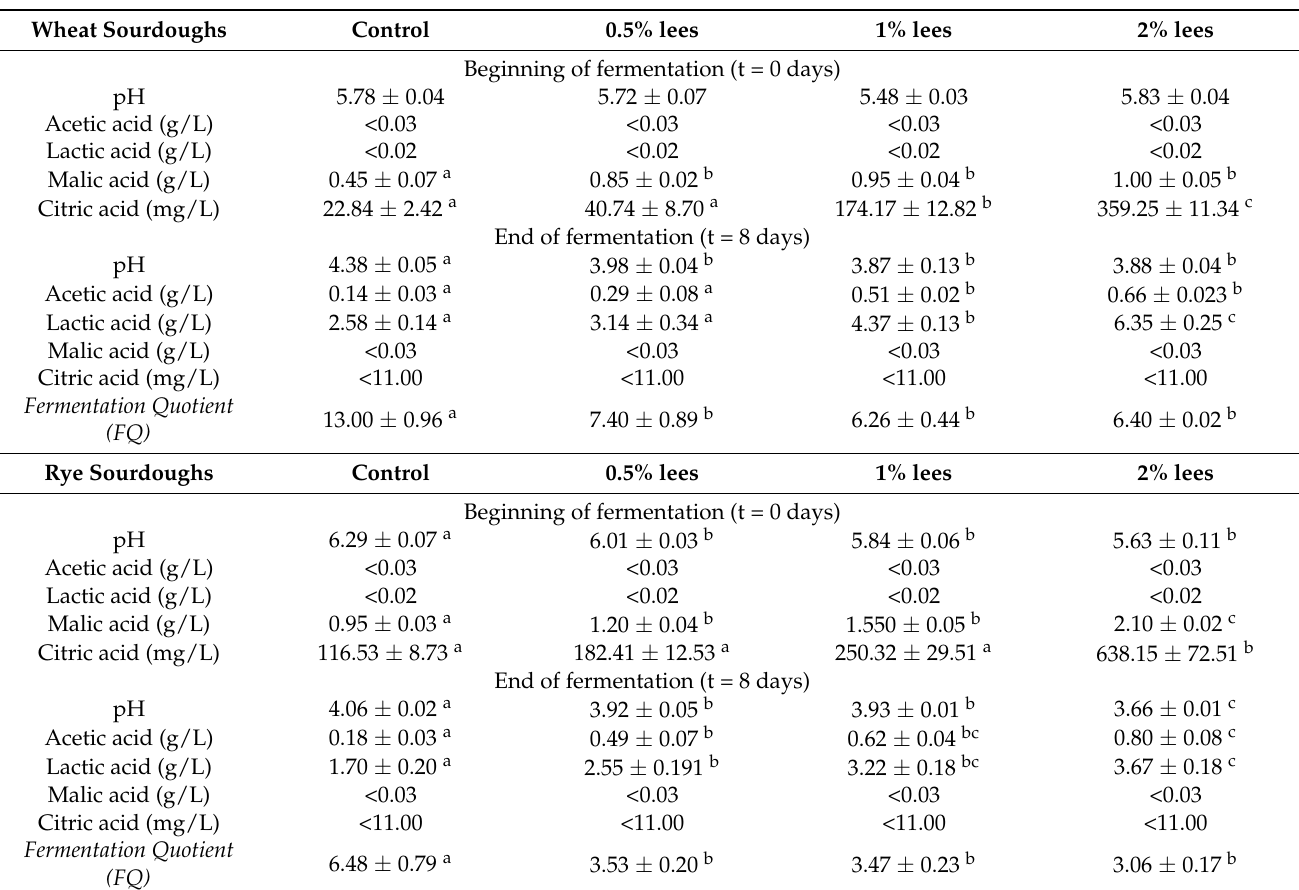
Table 2. Physicochemical characterization of sourdoughs (both wheat and rye) and fermentation quotient